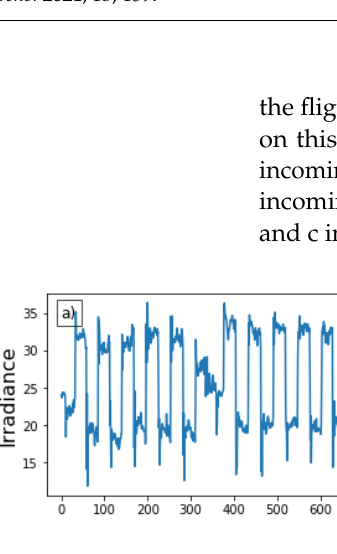
Figure 5. Sunshine sensor data plot showing variation of irradiance within UAV missions. These plots ( a – c ) refers to UAV flights during sunny, overcast sky, and complex light conditions respectively.